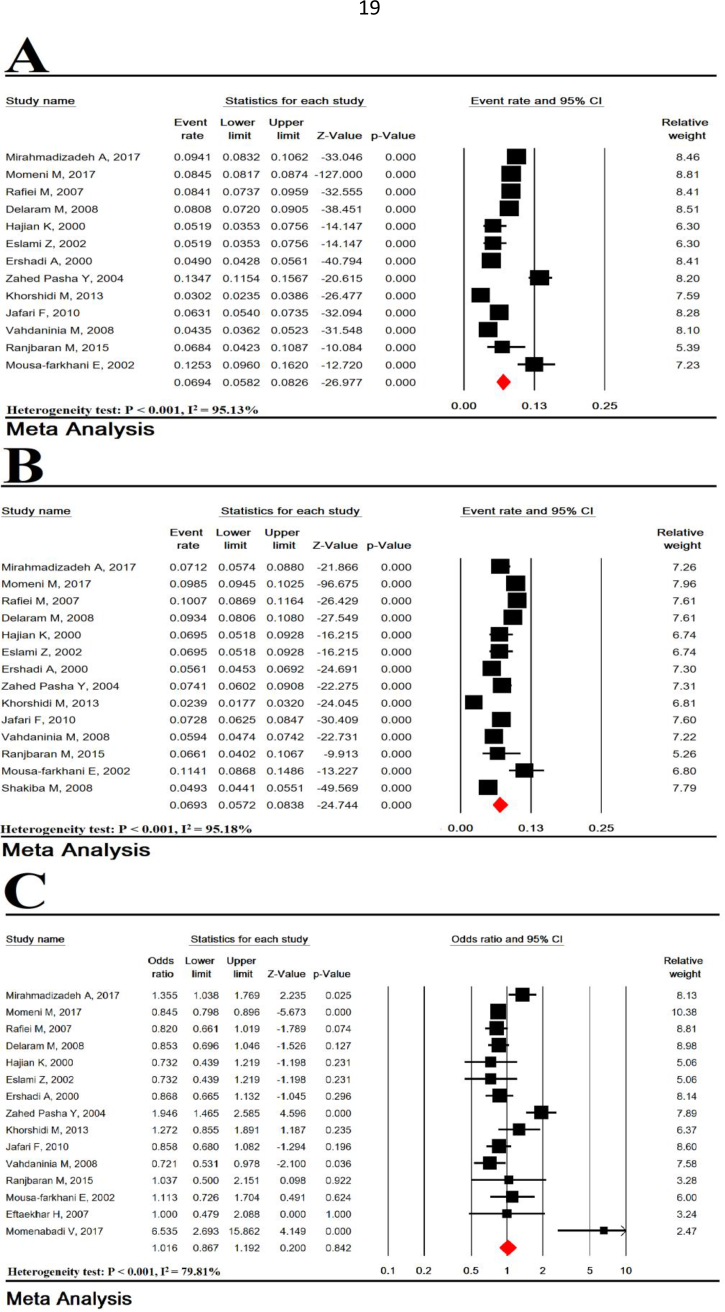
Prevalence of LBW in studies of urban (A), rural (B), and an odds ratio of urban -to- rural (C).